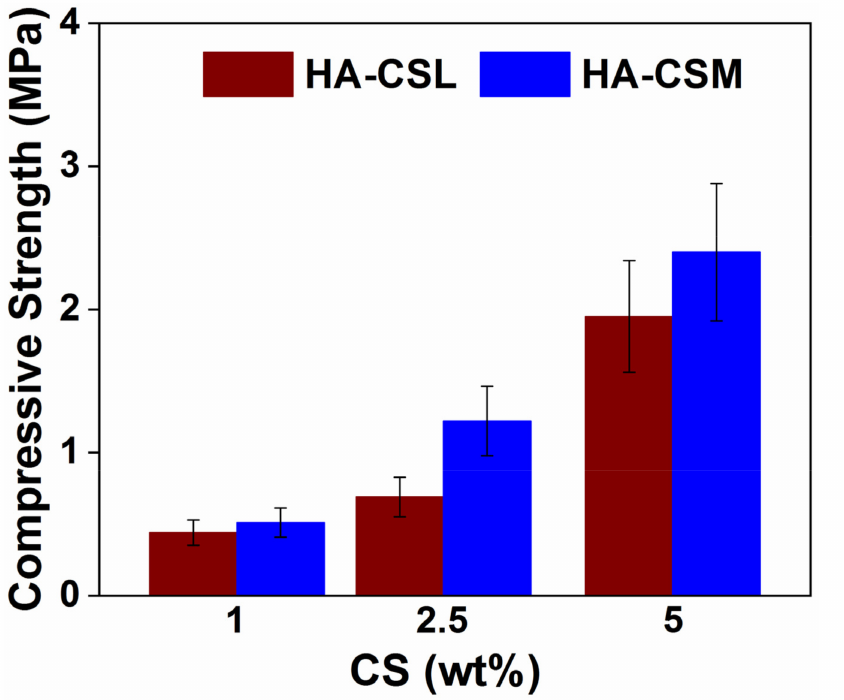
Figure 5. Influence of the polymer content (1, 2.5, and 5 wt%) and the molecular weight on the compressive strength of the HA-CS composites formulated at a S/L value of